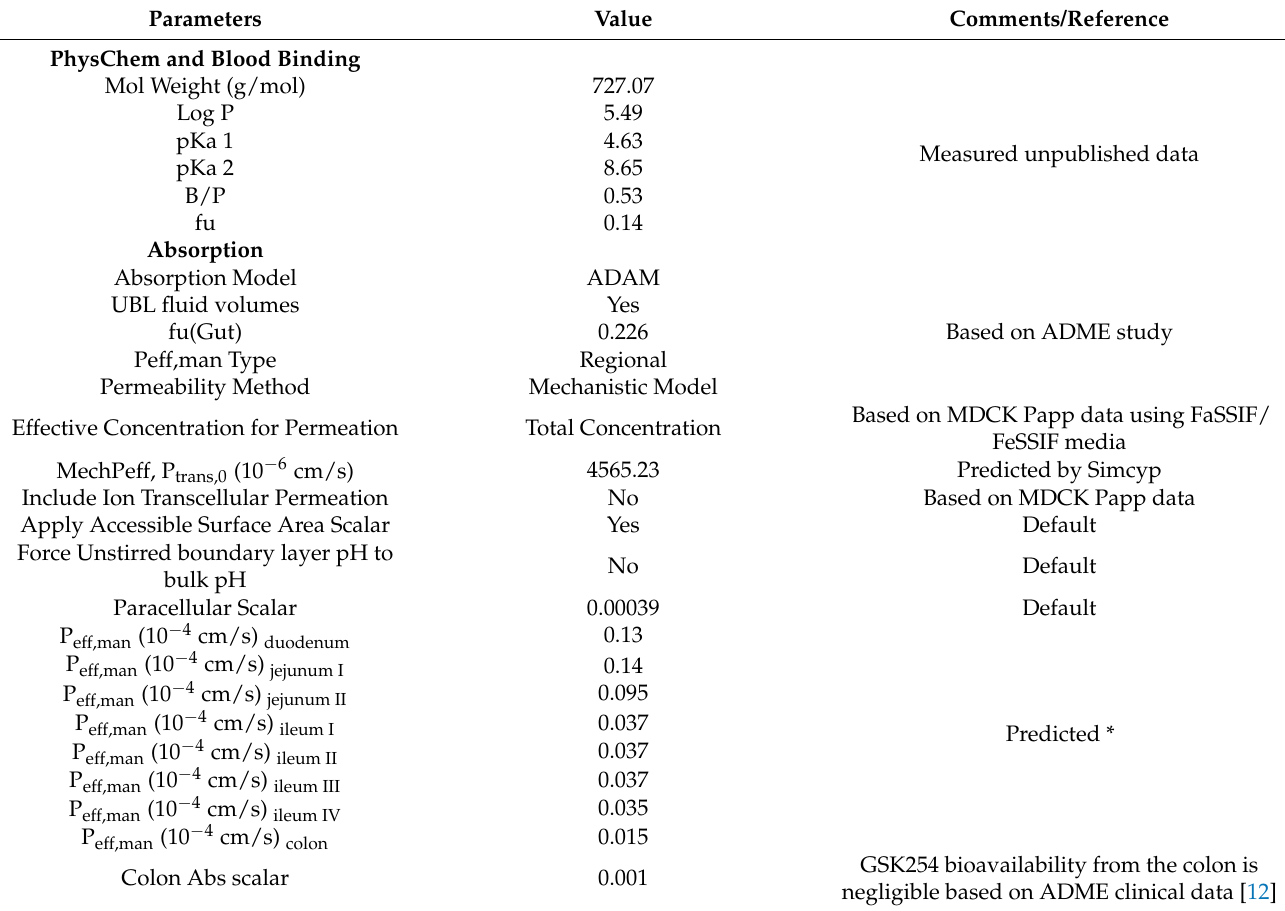
Table 3. GSK254 PBBM model input